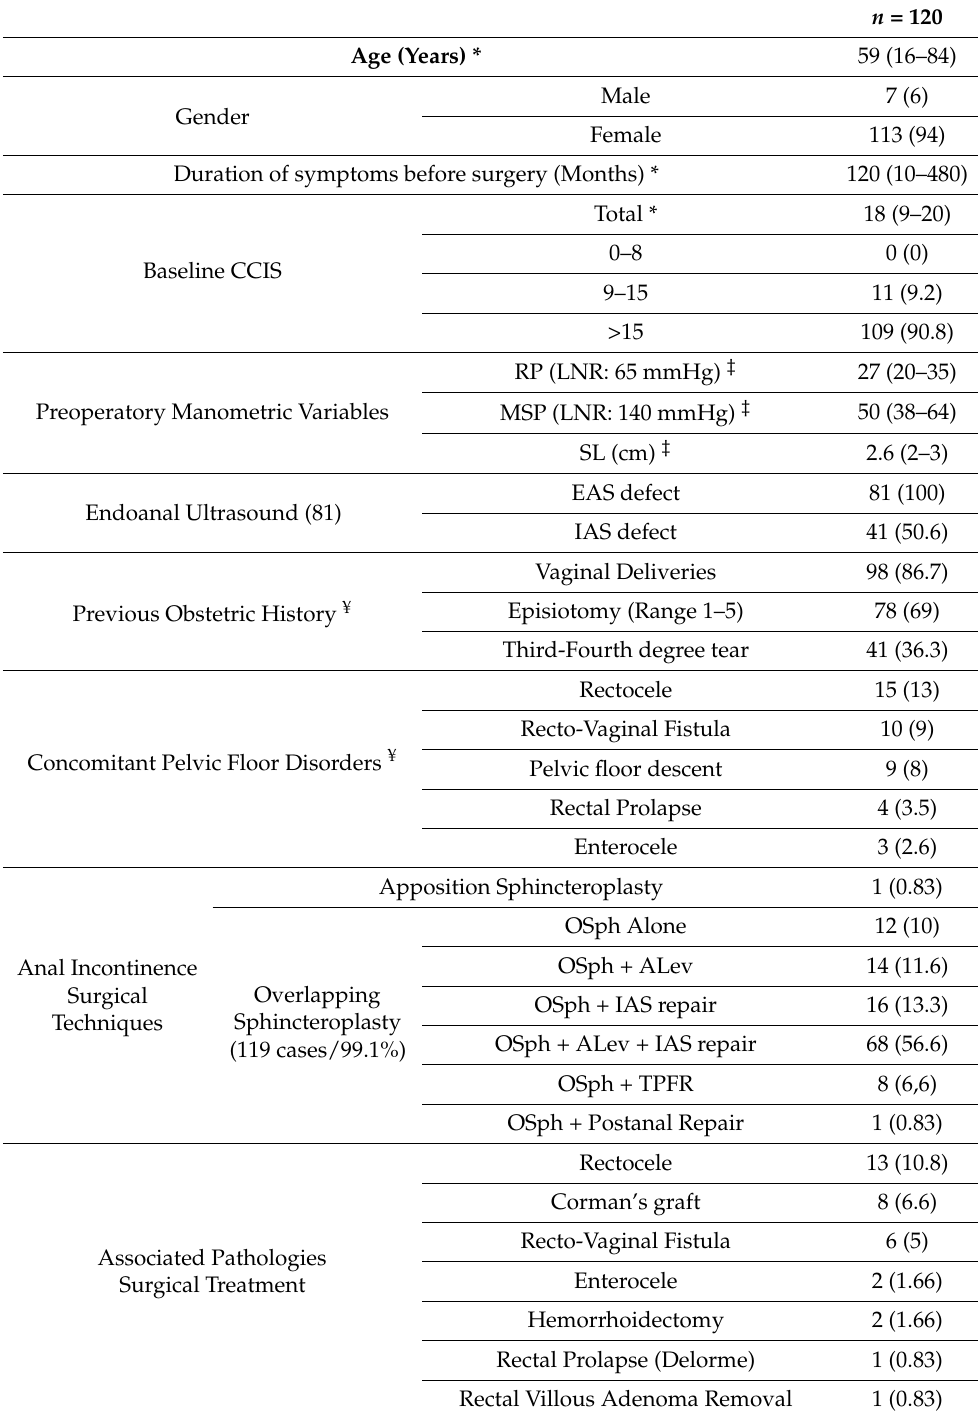
Table 1. Demographic, preoperative and operative data for the whole